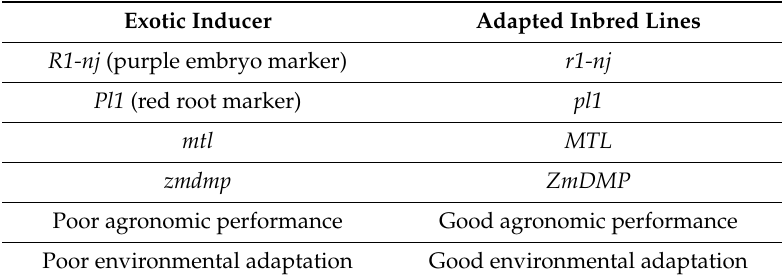
Table 3. Traits of the exotic inducer and noninducer parents assumed for the comparison of the di ff erent approaches for inducer